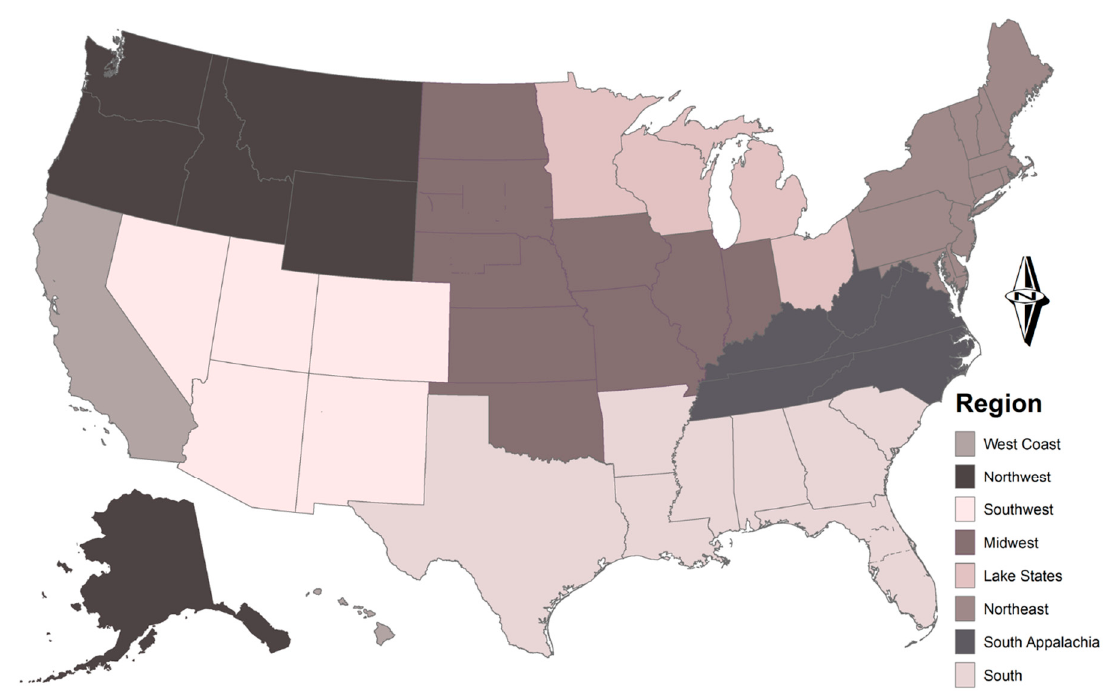
Figure 2. Map of regions used as indicator variables.